Question: Give a one-sentence summary of this figure.
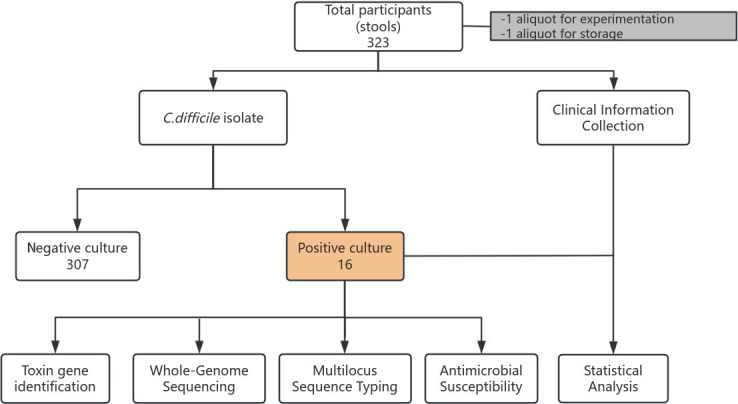
Answer: Susceptibility-toxin genotype correlation in 16 clinical C. difficile isolates